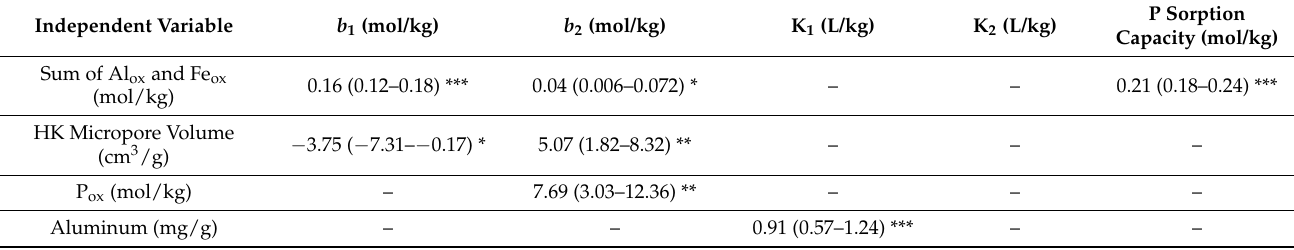
Table 5. Regression coefficients (95% confidence intervals of coefficients) for five final linear regression models (n = 18). The model for high-affinity capacity, b 1 , F(2,15) = 60.3 ( p < 0.001) adjusted R 2 = 0.87 had two significant factors ( α = 0.05). The model for low-affinity capacity, b 2 , F(3,14) = 25.6 ( p < 0.001) adjusted R 2 = 0.81 had three significant factors. The model for high-affinity binding energy constant, K 1 , F(1,16) = 35.0 ( p < 0.001) adjusted R 2 = 0.67 had one significant factor. No factors were significantly associated with the low-affinity binding energy constant, K 2 . The model for total P sorption capacity F(1,16) = 253 ( p < 0.001) adjusted R 2 = 0.94 had one significant factor.